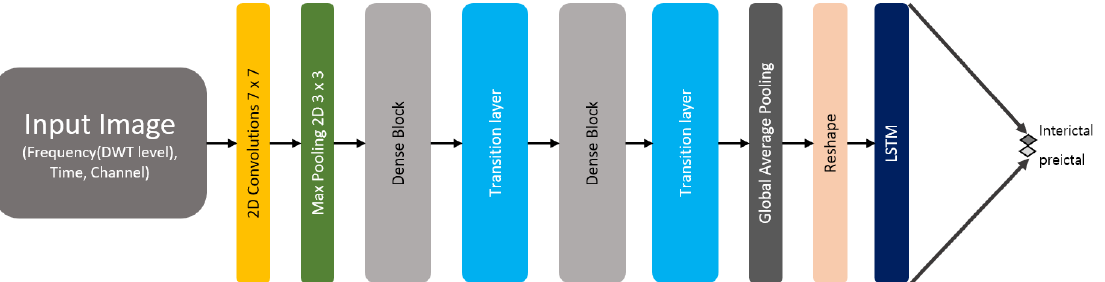
Figure 8. Architecture of